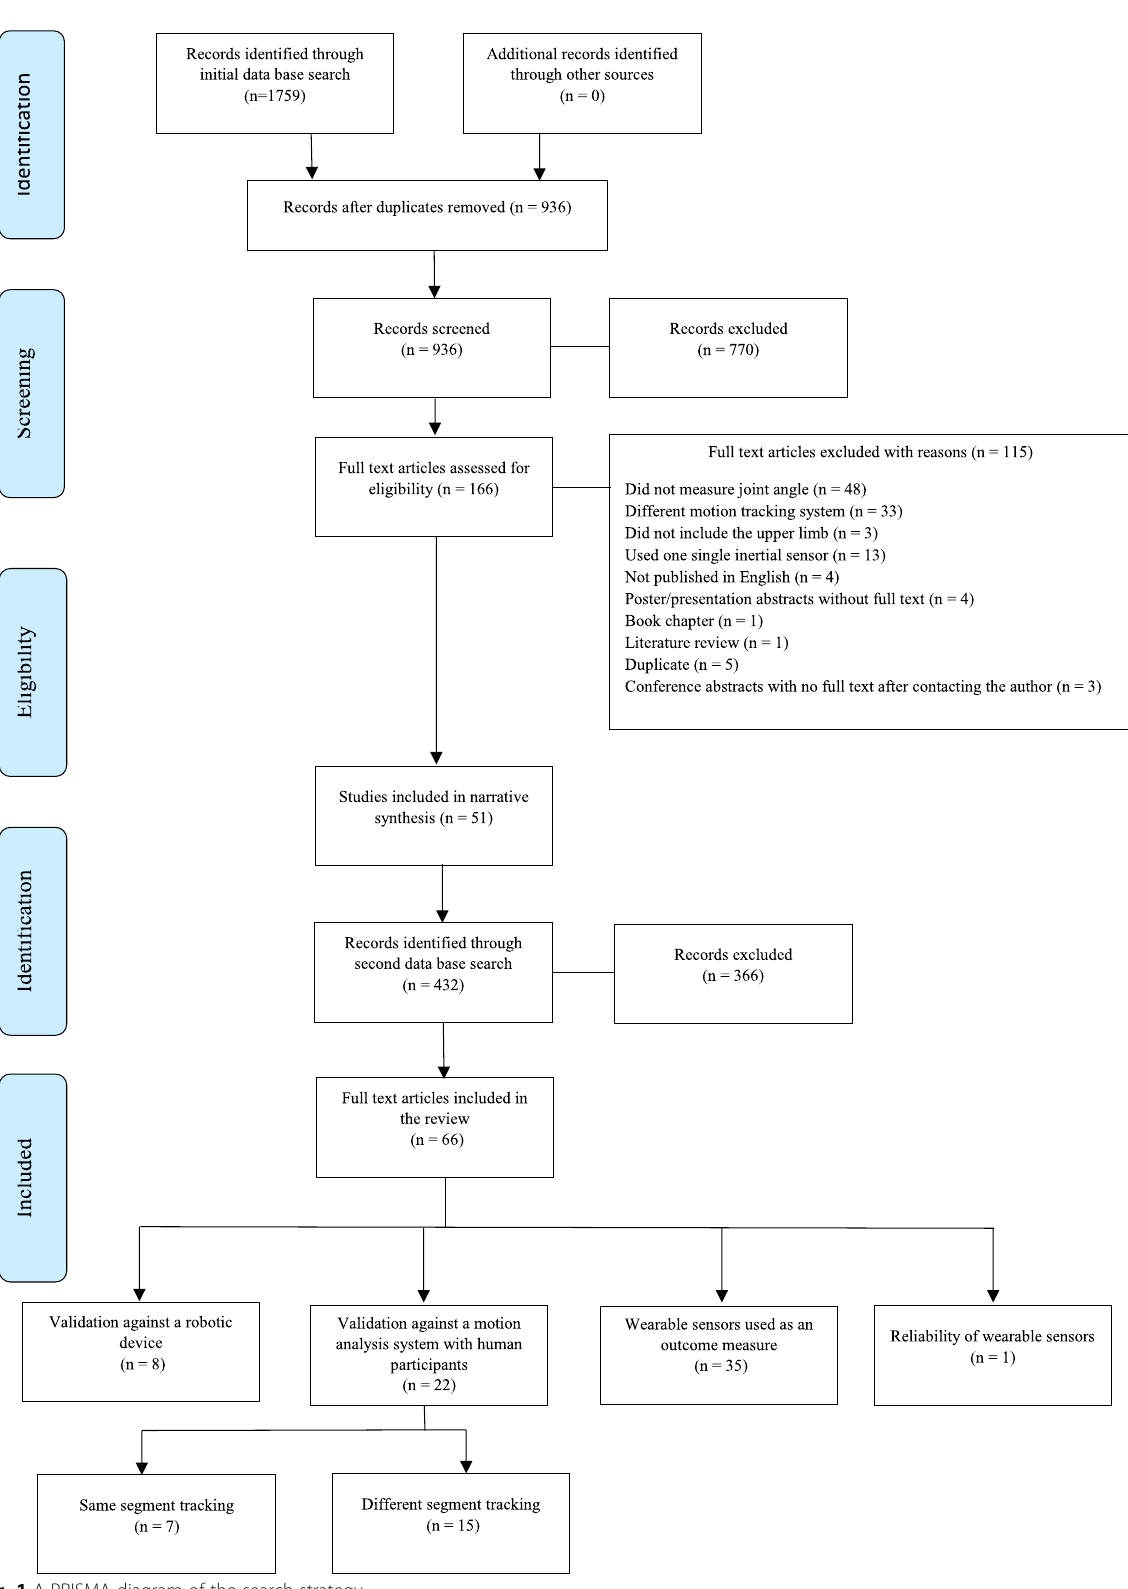
Fig. 1 A PRISMA diagram of the search